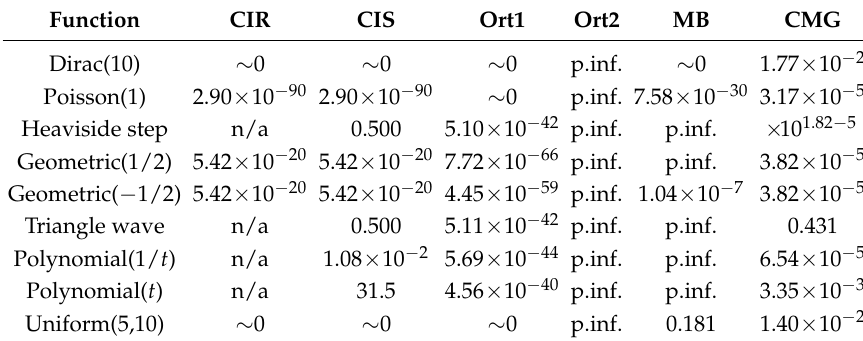
Table 2. Errors for various test functions ( N = 64, T max = 32, a = 1).